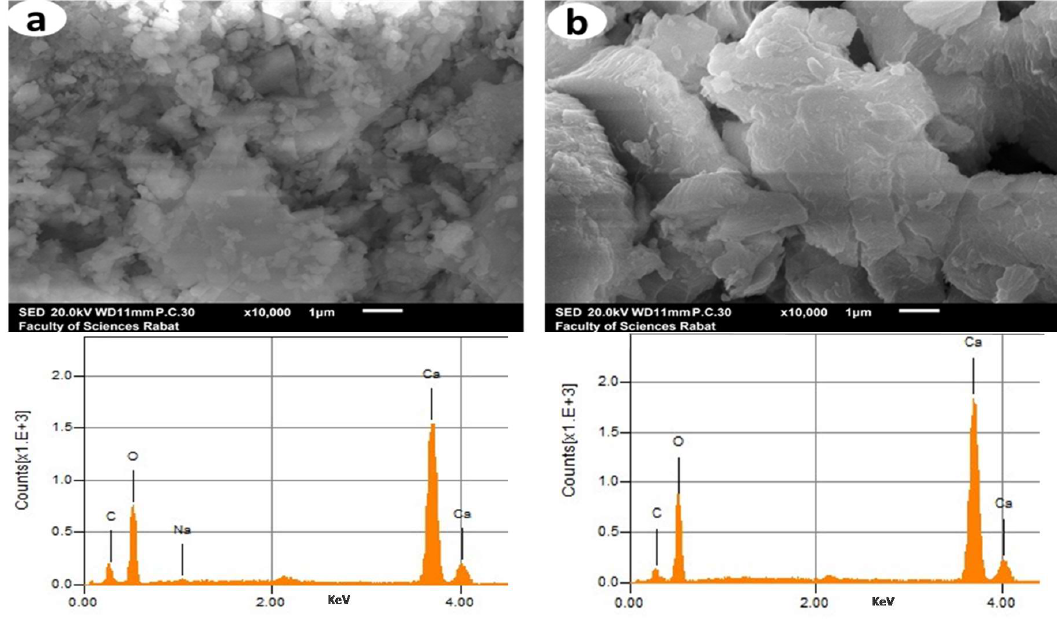
Figure 4. SEM morphology and EDX analysis of ( a ) the uncalcined GRS shell and ( b ) the resulting material calcined at 900 °C.